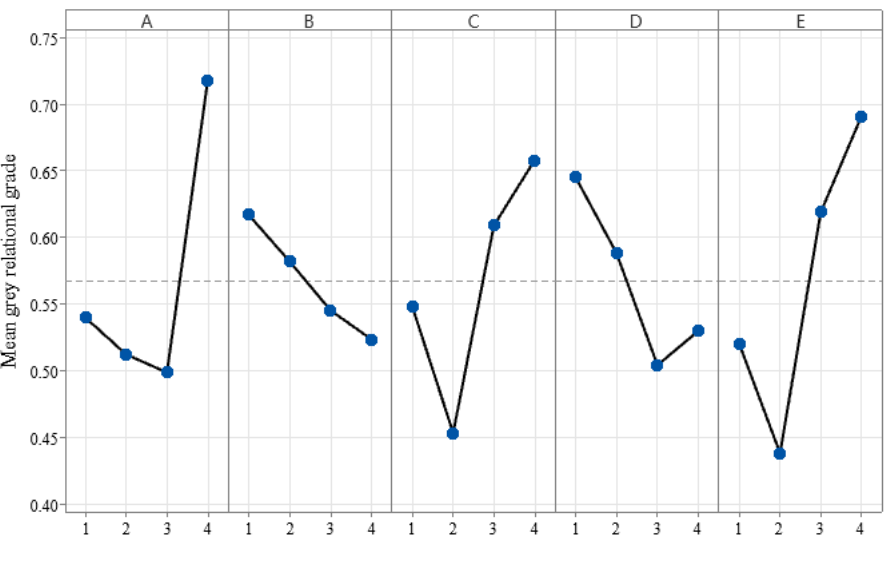
Figure 10. Main effects of factor level.